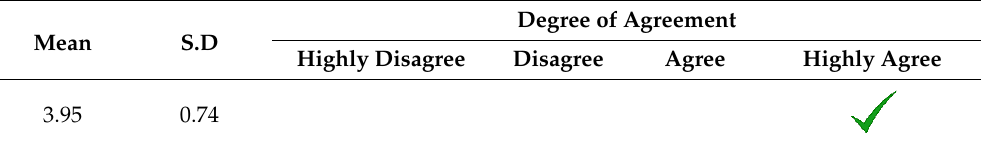
Table 3. Responses to Question Table 6. Responses to Question 3-b. Table 6. Responses to Question 3-b.